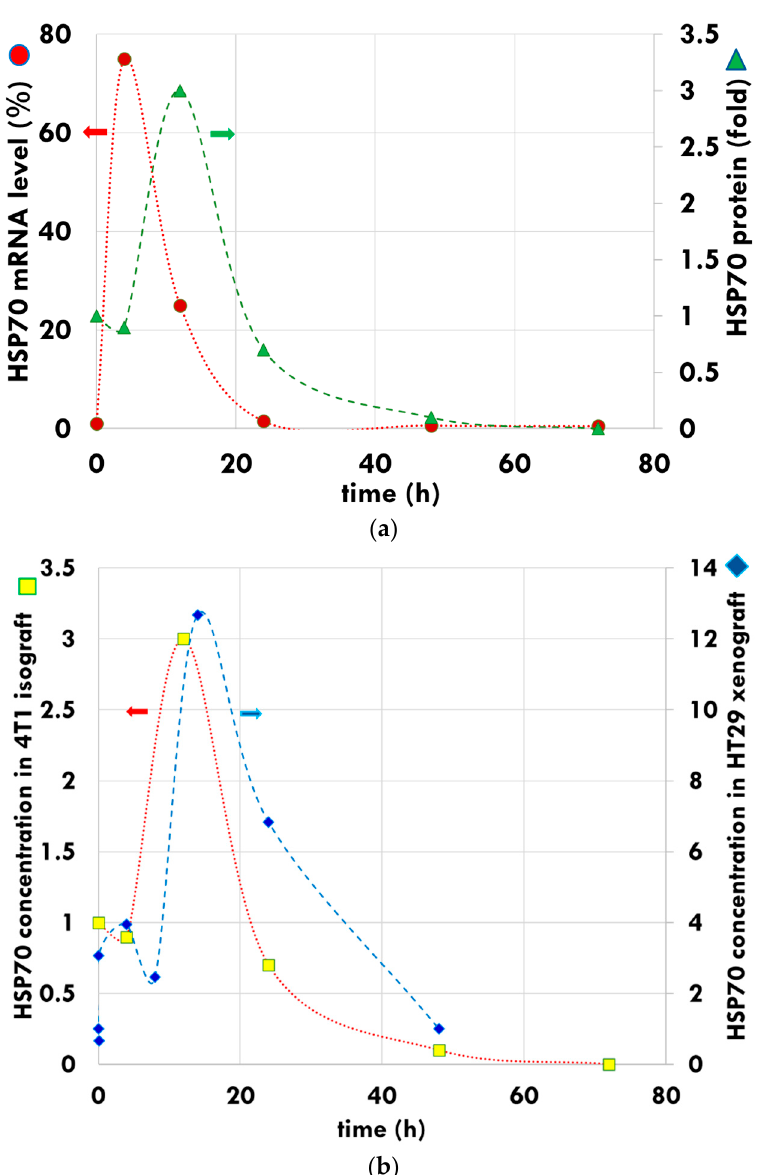
Figure 5. Development of iHSP by mEHT. ( a ) The HSP70 peak is indicated at mRNA level (dots, left axis) approximately eight hours earlier than the measured HSP70 folded protein peak (triangles, right axis). ( b ) The HSP peak has similar features in the measurements of the 4T1 isograft (square, left axis) and HT29 xenograft (diamond, right axis). The curves are for guiding the eye. It is clearly shown that the up-regulation of the HSP70 in the HT29 xenograft model treated with mEHT increases, peaking at 14 h post-treatment, followed by a decline and a return to baseline levels at 48 h. The distribution of HSP70 shows a large increase in iHSPs during this first peak. The second peak in HSP expression occurs between 72 and 120 h post-treatment, followed by a return to baseline levels after 168 to 216 h post-treatment (Figure 6). The second peak is likely a result of the release of mHSPs into the extracellular environment producing eHSPs [101].